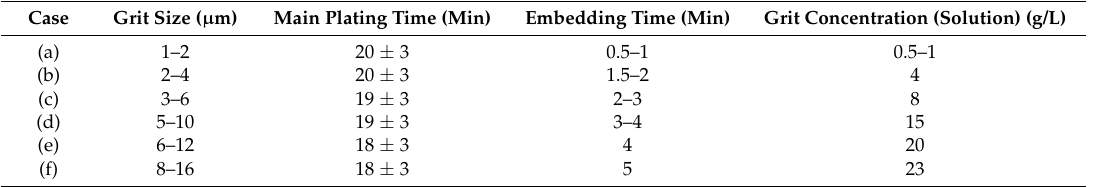
Figure 5. Electroless plated MPGTs with grit sizes ( a ) 1–2 µm; ( b ) 2–4 µm; ( c ) 3–6 µm; ( d ) 5–10 µm; ( e ) 6–12 µm, and ( f ) 8–16 µm. Table 2. Plating parameters for MPGTs with a 50 µm tool.